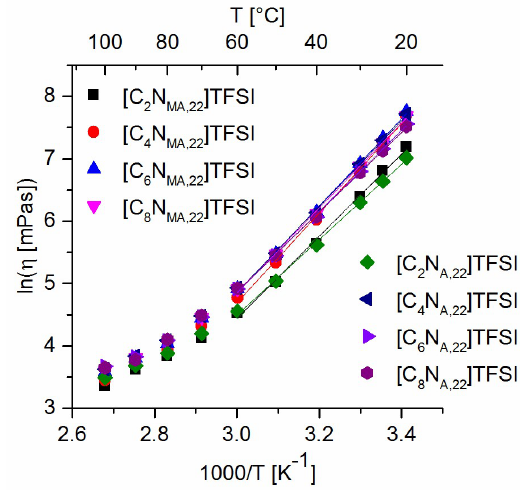
Figure 6. Arrhenius fit of viscosity values.